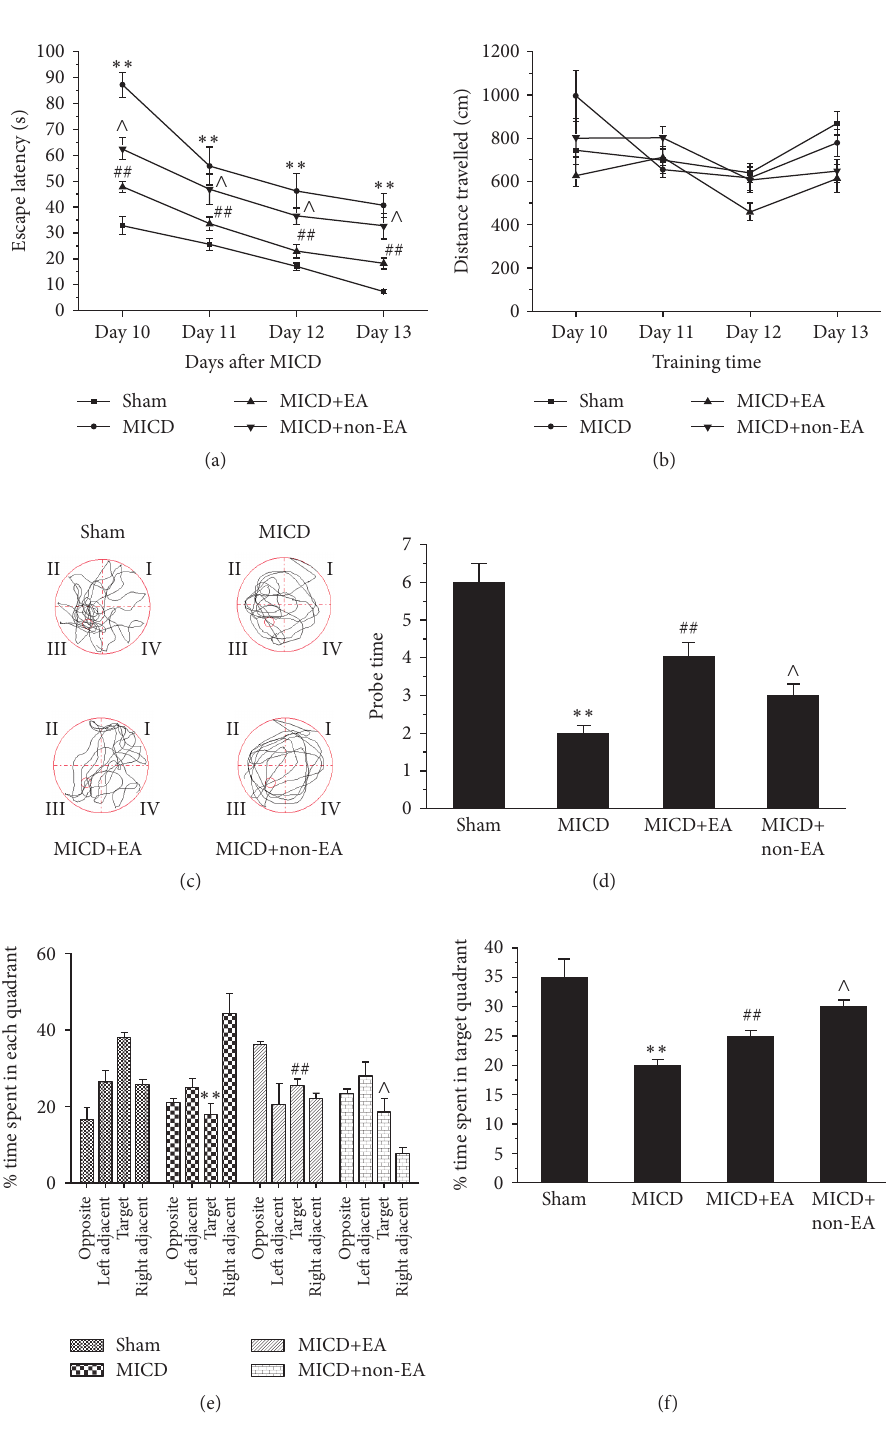
Figure 2: Evaluation of spatial reference learning and memory by Morris water maze test at Days 10–14 after EA. (a and b) Mean escape latency time and path length during the orientation navigation test on Days 10–13 after EA treatment. (c and d) Times the rats crossed over previous platform location on Day 14 after EA treatment during the spatial memory test in different groups. (e) The percentage of times spent in each quadrant in all probe trials is shown on Day 14 after EA treatment. (f) The times of passing the hidden platform position on Day 14 after EA treatment (each group; ∗∗ 𝑝 < 0.01 versus the Sham group; ## 𝑝 < 0.01 , # 𝑝 < 0.05 versus the MICD group; ∧∧ 𝑝 < 0.01 , ∧ 𝑝 < 0.05 versus the MICD+EA group). EA: electroacupuncture. MICD: middle cerebral artery occlusion induced cognitive